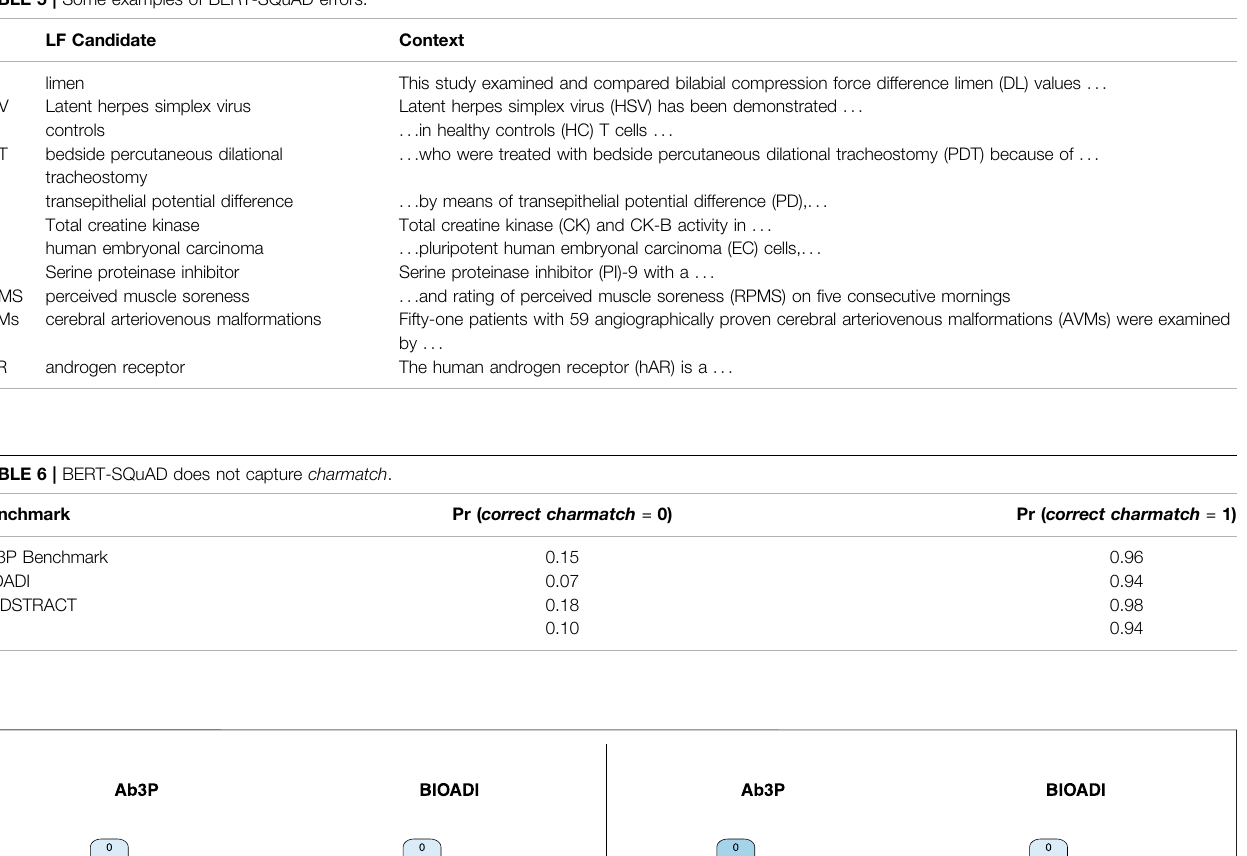
TABLE 5 | Some examples of BERT-SQuAD